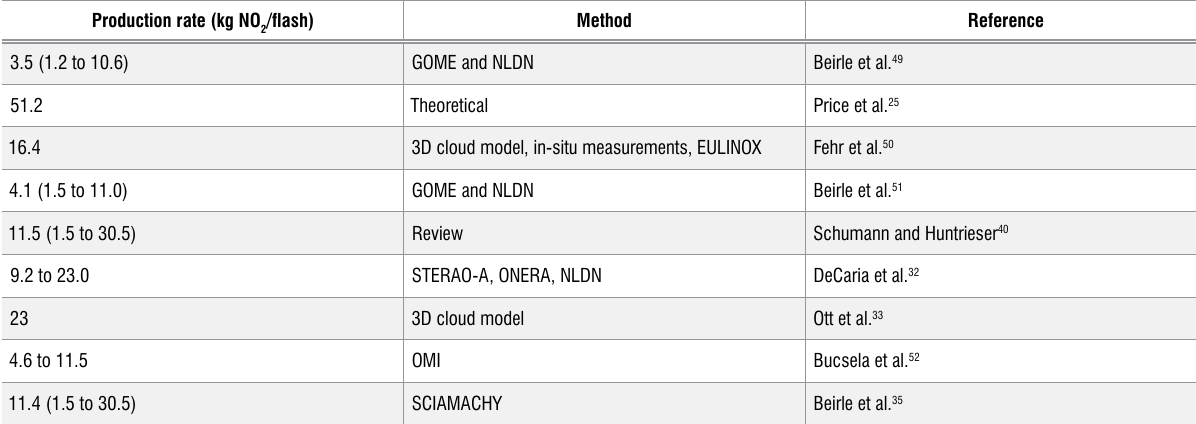
Estimates of LNO production per flash from different studies x Production rate (kg NO 2